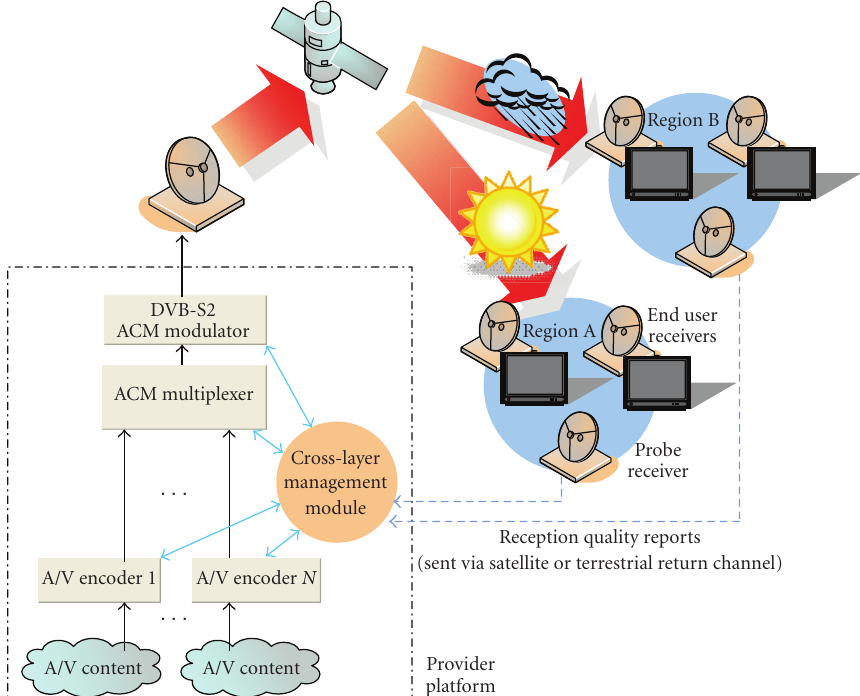
Figure 2: Proposed reference architecture for Broadcasting with